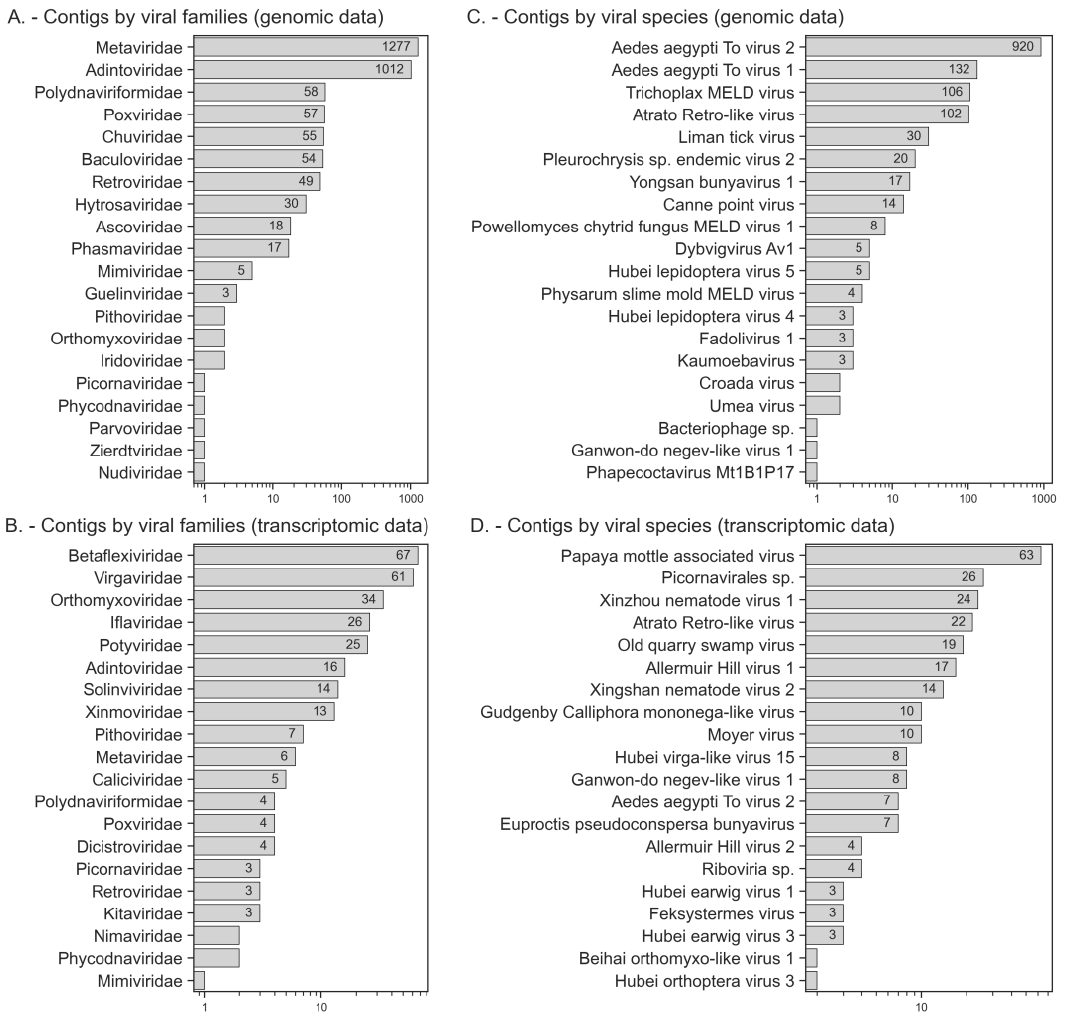
Figure 3. The number of virus-positive contigs by virus family in genomic ( A ) and transcriptomic ( B ) samples. The distribution of virus-positive contigs by virus species (unknown family) in the genomic ( C ) and transcriptomic ( D ) samples.